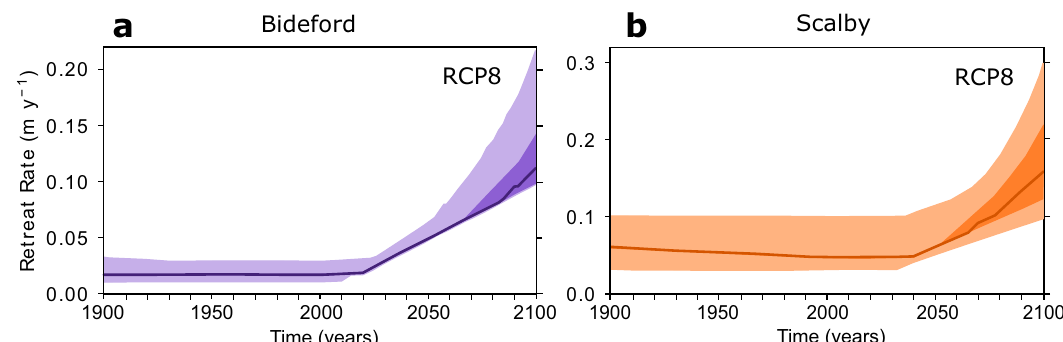
Fig. 4 | Model forecasts of future cliff retreat rates for Representative Con- centration Pathway RCP8 future sea-level scenario. Bideford ( a ) and Scalby ( b ). Lightest-shaded areas combine model uncertainty with 5th – 95th RCP8 sea-level